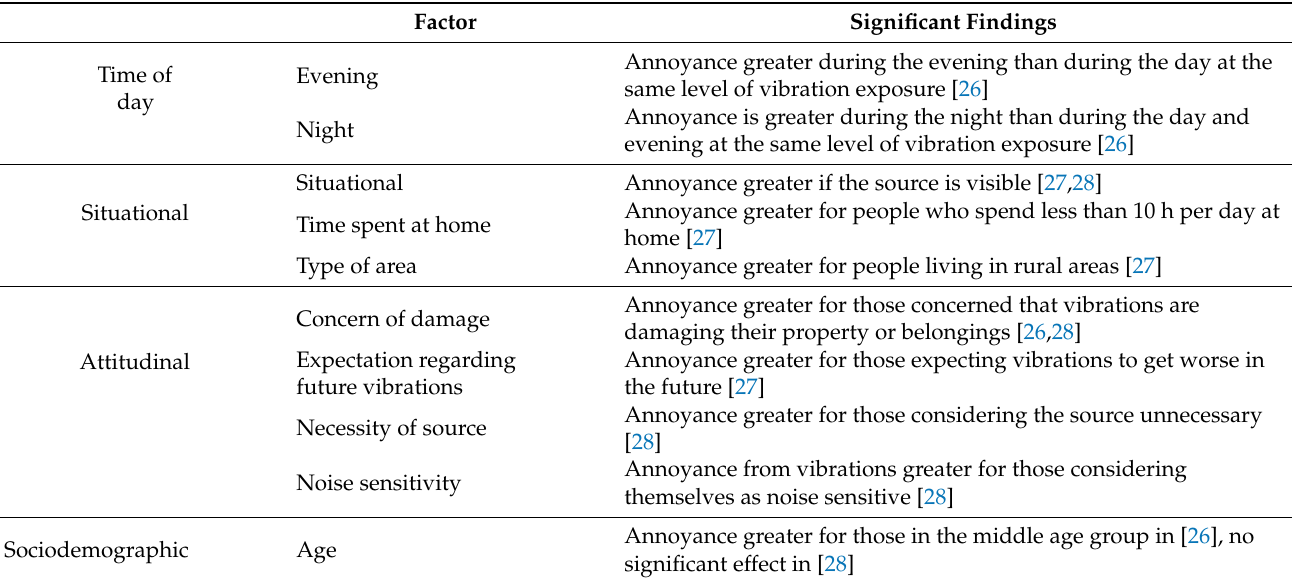
Table 2. Summary of the effects of the situation, attitudinal, and socio-demographic factors on annoyance [16]. Factor Significant